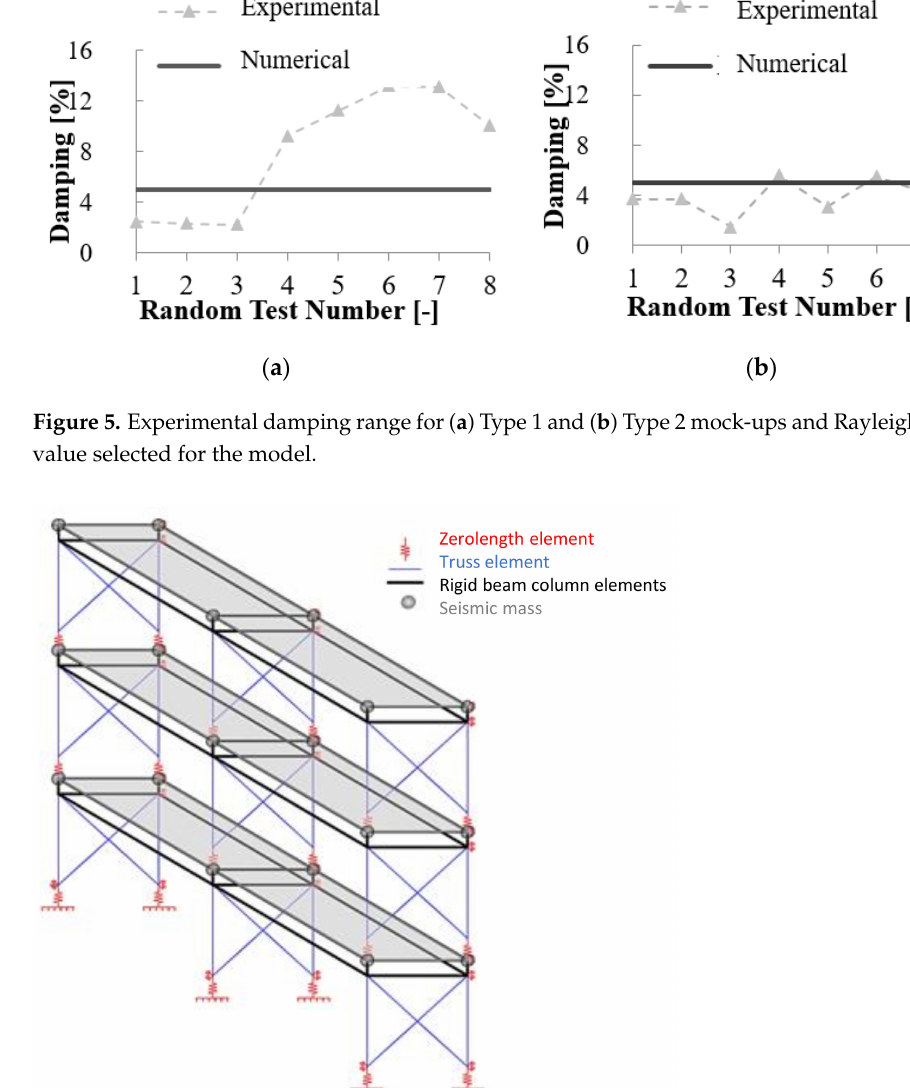
Figure 4. A two-node parallel spring element used for hold-downs [42].